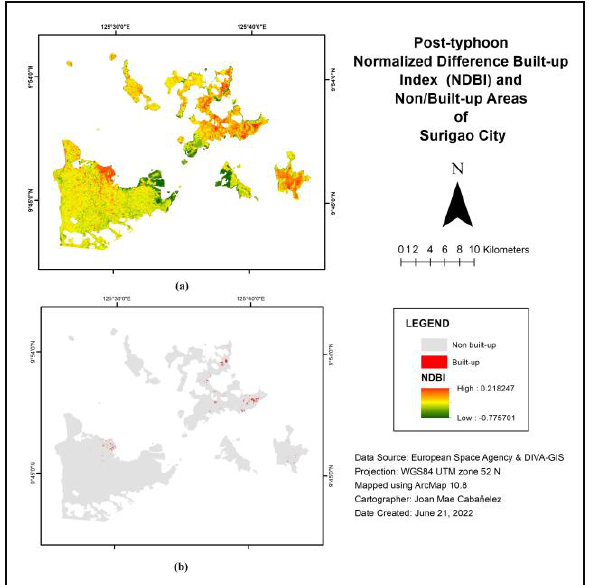
Figure 12 . NDBI and built-up layers of Surigao City during post-typhoon condition.